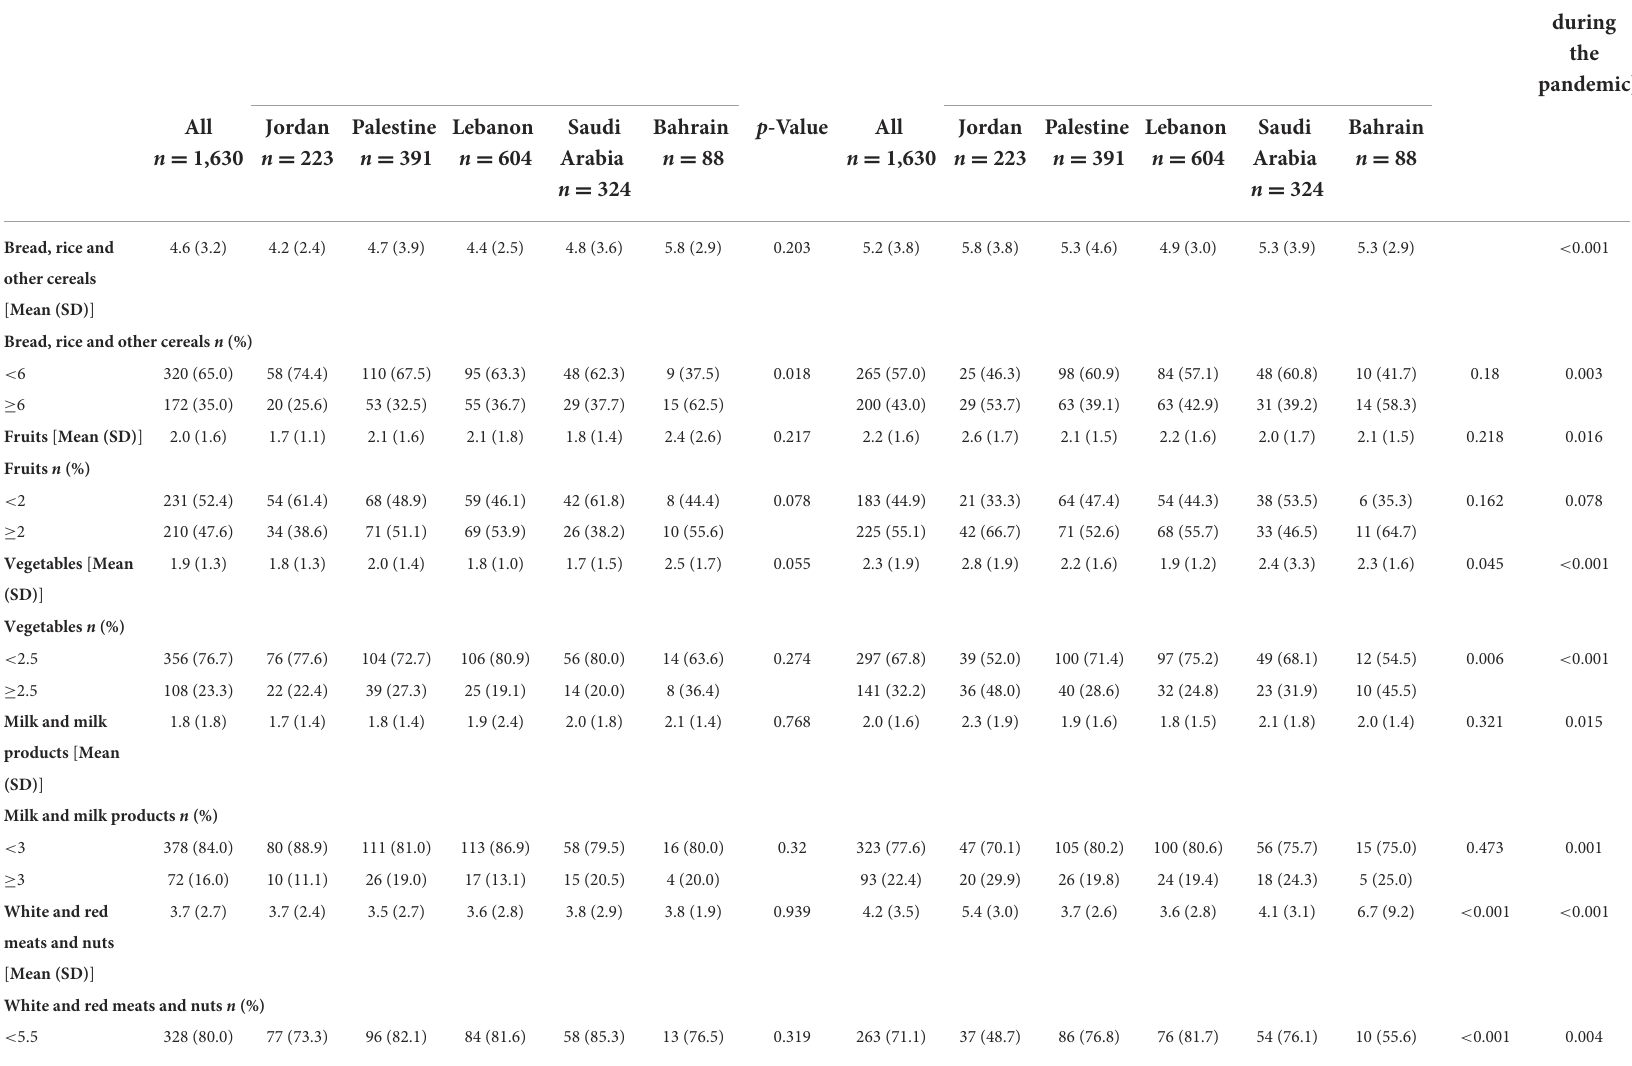
TABLE 3 Daily intake of the main food groups per country according to USDA. Food